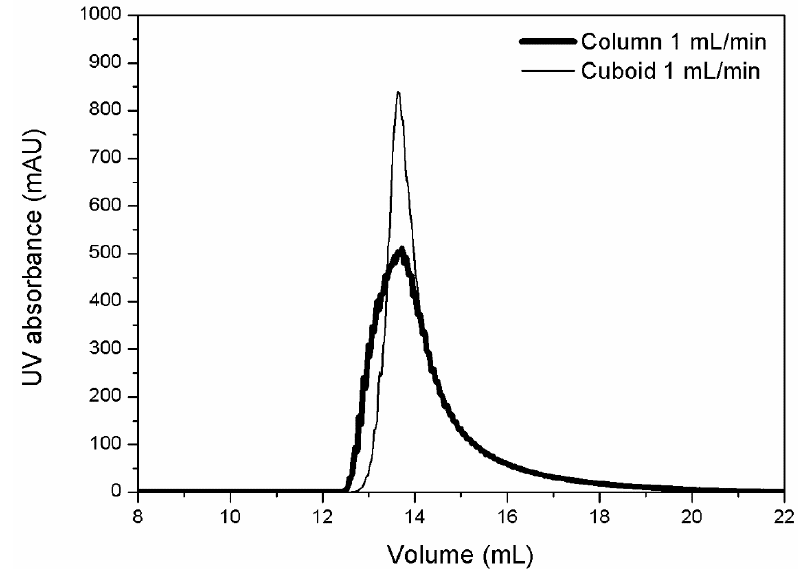
Figure 8. Eluted BSA peaks obtained with the best cuboid packed-bed device and its equivalent column (media: Capto Q anion exchange, bed volume: 5 mL, binding buffer: 50 mM Tris-HCl, pH 8.0, eluting buffer: 50 mM Tris-HCl, 1 M NaCl, pH 8.0, sample: 2 mg/mL BSA, loop: 5 mL, flow rate: